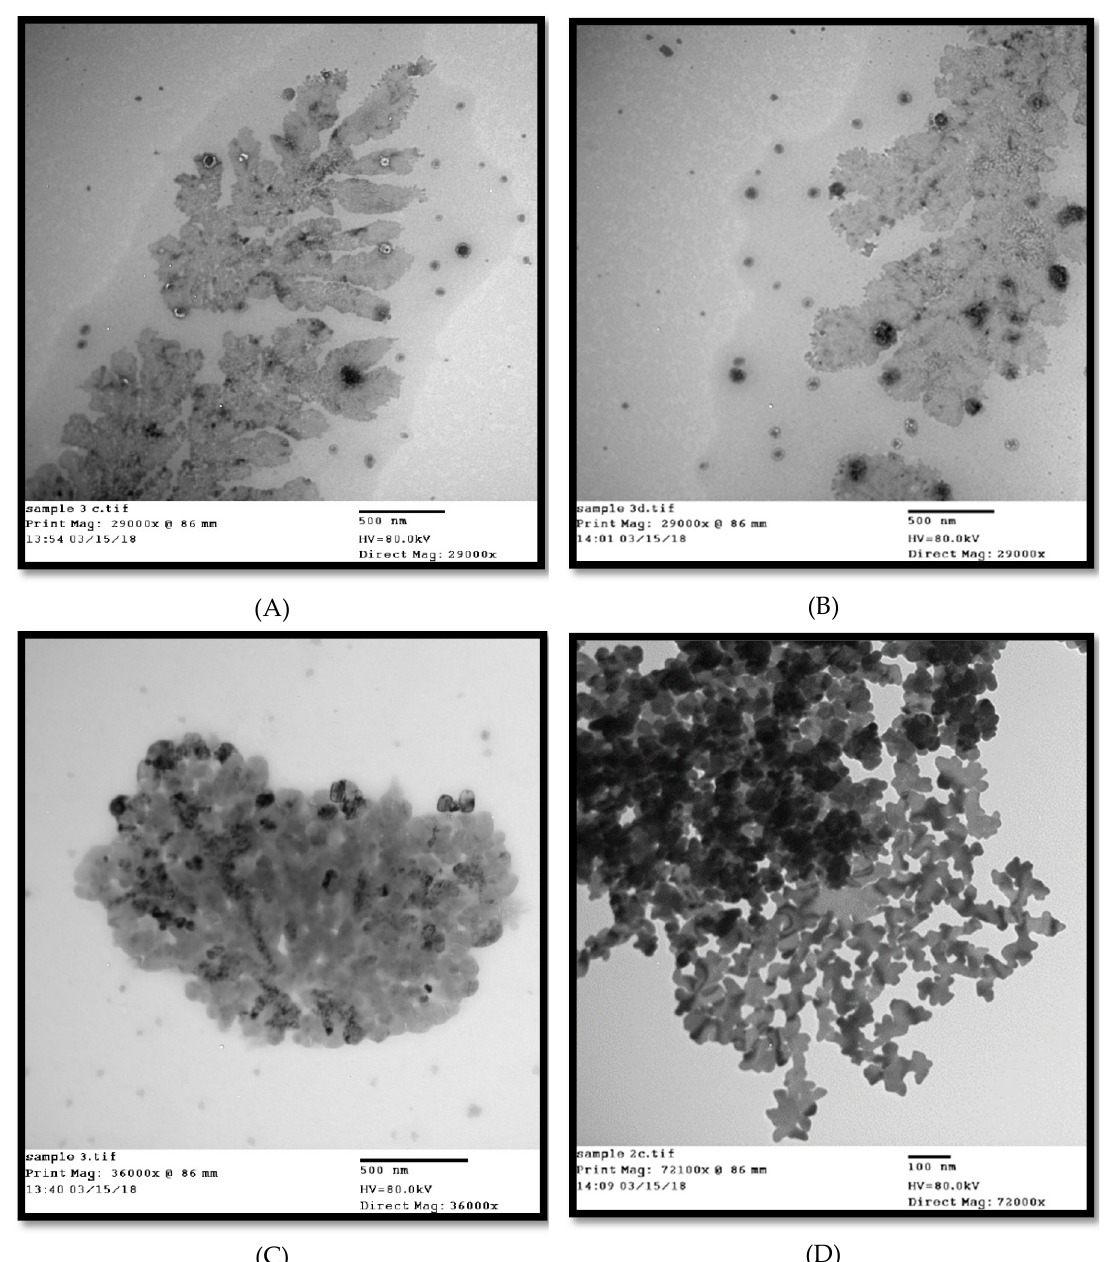
Figure 5. Transmission electron microscope (TEM) micrograph of E. coli treated with silver nitrate showing aggregation to the bacterial cells with disfigured and irregular membranes. Images showed the adsorption of AgNPs on the surface of the bacterial cells and their penetration causing cells damage ( A , B , C , and D ). Images A and B showed AgNPs released from the cell to the surrounding environment.